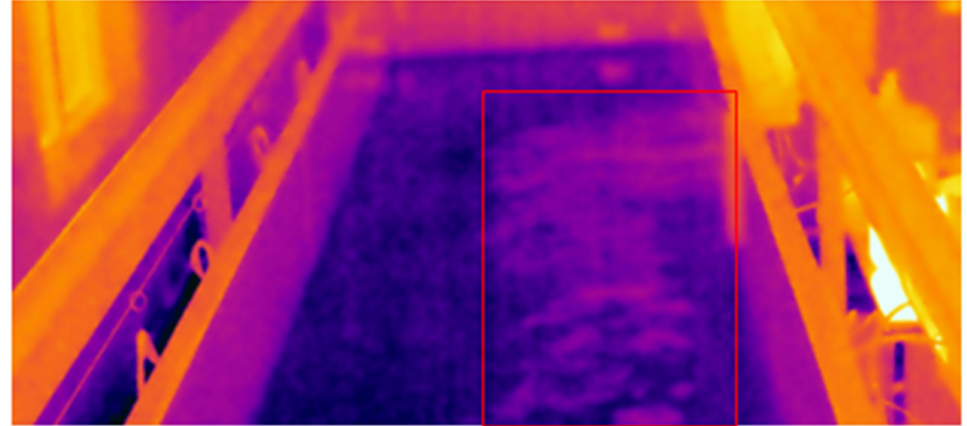
Figure 16. Surface temperature of the thermal jet from the circle discharge port.